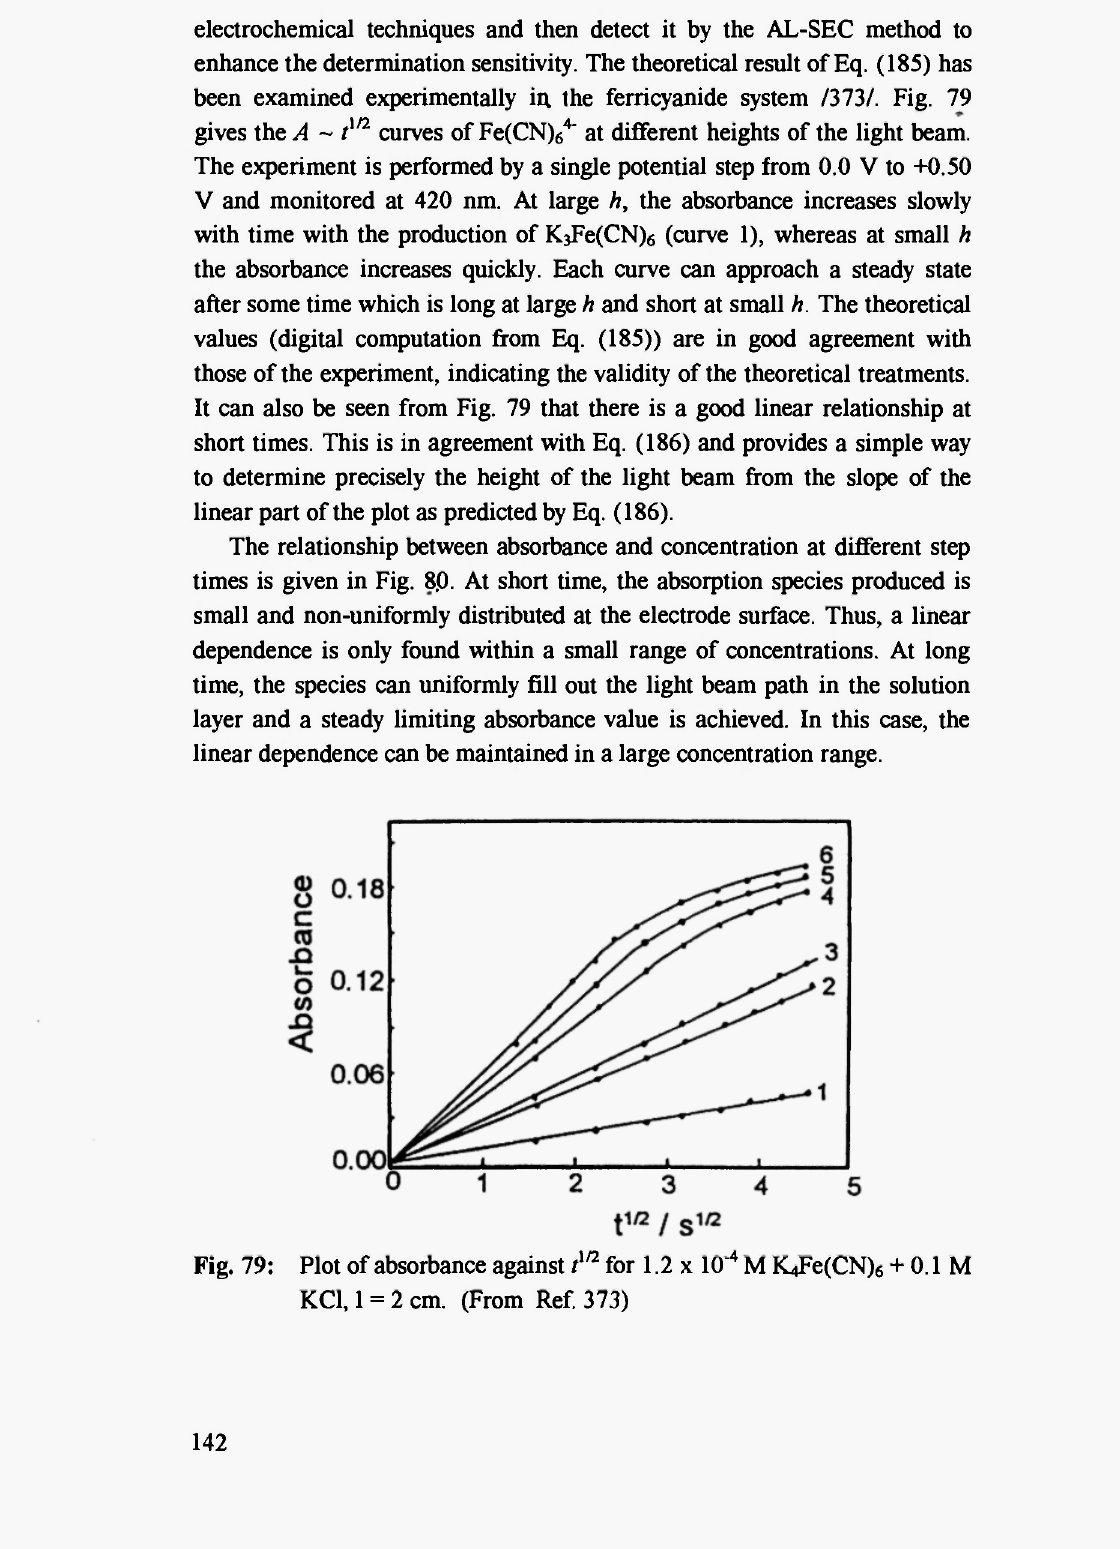
Fig. 79: Plot of absorbance against t m for 1.2 χ ΙΟ" 4 Μ K4Fe(CN) KCl, 1 = 2 cm. (From Ref.